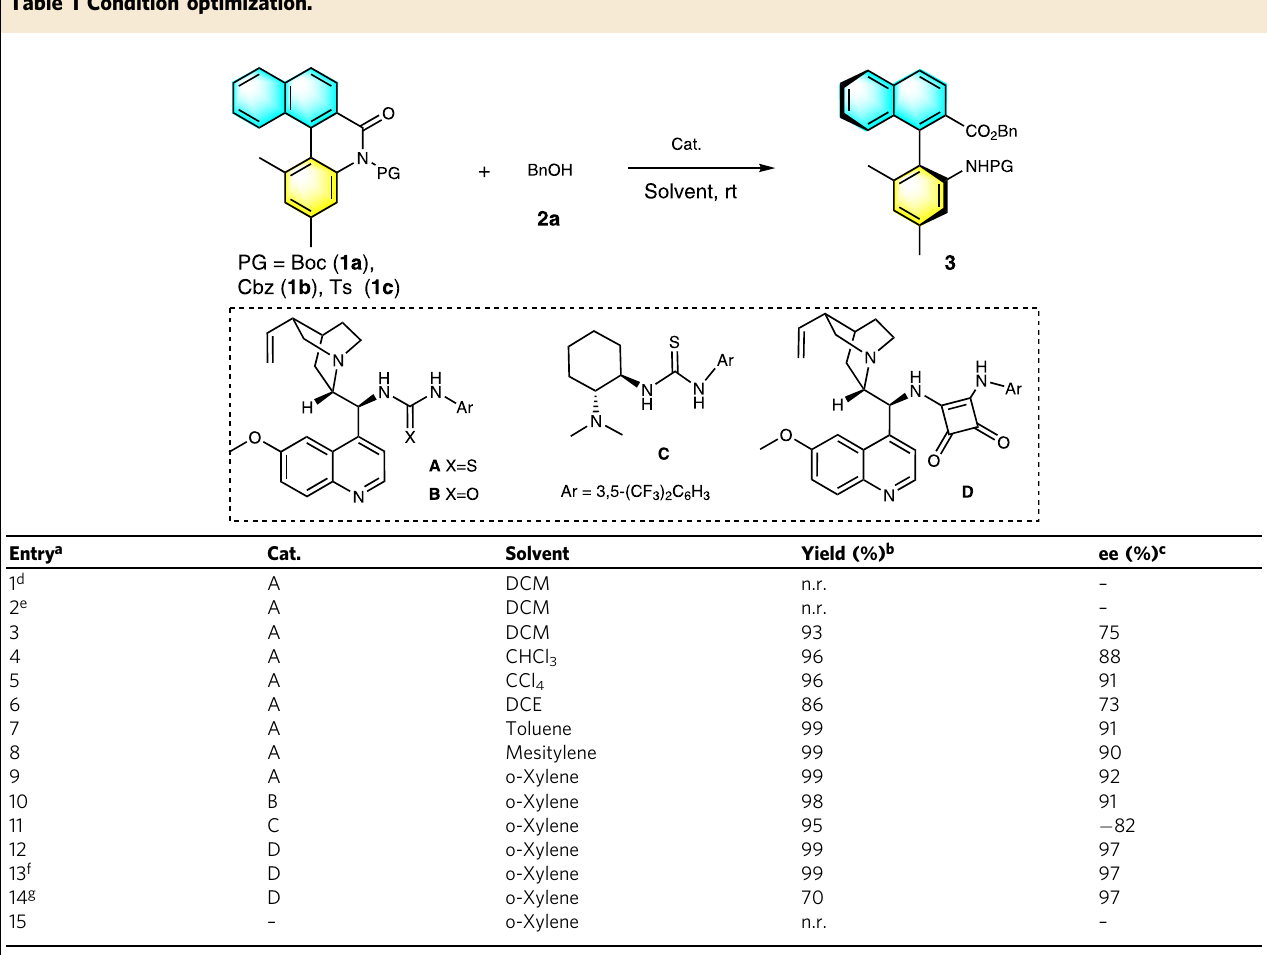
Table 1 Condition